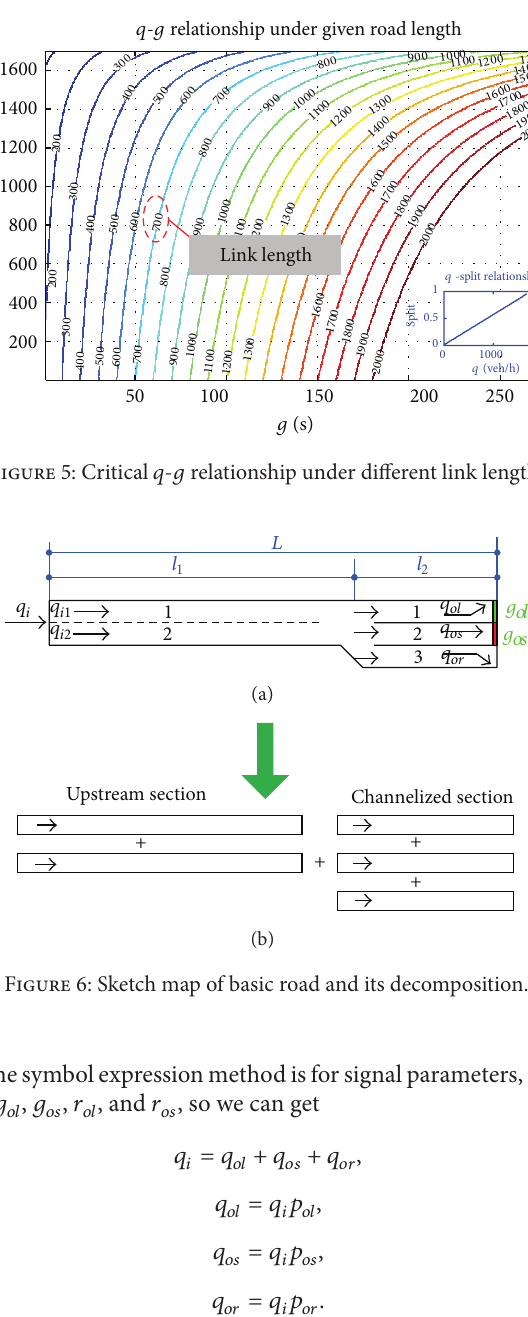
Figure 6: Sketch map of basic road and its decomposition.